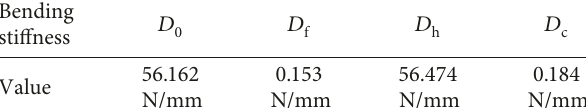
Table 1: Different rigidities of the sandwich plate.